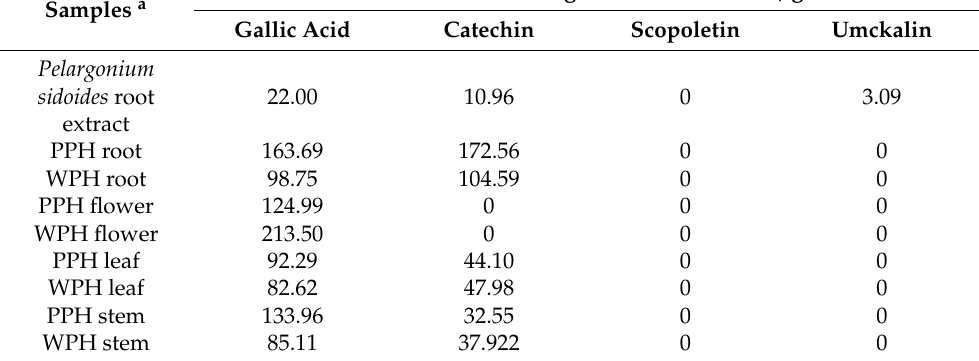
Table 1. HPLC-UV assay results of detected catechin, gallic acid, scopoletin, and umckalin content at a wavelength of 210 nm using RP-C 18 column, in pelargonium sidoides and two Pelargonium × hortorum cultivars; with pink flowers (PPH) and with white-to-rose flowers (WPH). Concentrations of Investigated Biomolecules ( µ g/mL) b Samples a Gallic Acid Catechin Scopoletin Umckalin Pelargonium sidoides root 22.00 10.96 0 3.09 extract PPH root 163.69 172.56 0 0 WPH root 98.75 104.59 0 0 PPH flower 124.99 0 0 0 WPH flower 213.50 0 0 0 PPH leaf 92.29 44.10 0 0 WPH leaf 82.62 47.98 0 0 PPH stem 133.96 32.55 0 0 WPH stem 85.11 37.922 0 0 a Different extracts were analyzed at a concentration of 10 mg/mL. b The detected concentrations are expressed as the means of triplicate